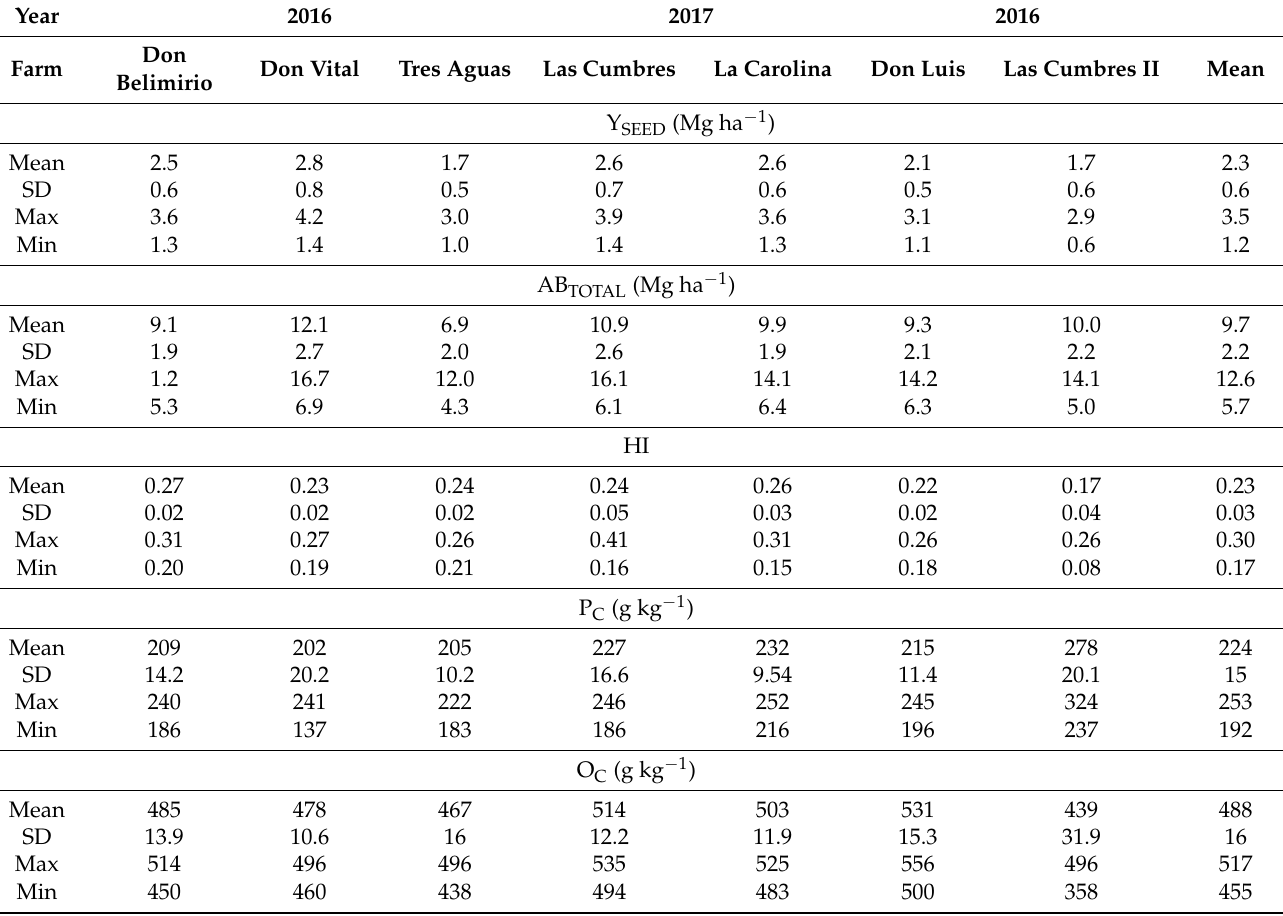
Table 2. Seed yield (Y SEED ), total aboveground biomass (AB TOTAL ), harvest index (HI), protein concentration (P C ), and oil concentration (O C ) for all of the sites and years evaluated. Mean, standard deviation (SD), maximum (Max) and minimum (Min) values are